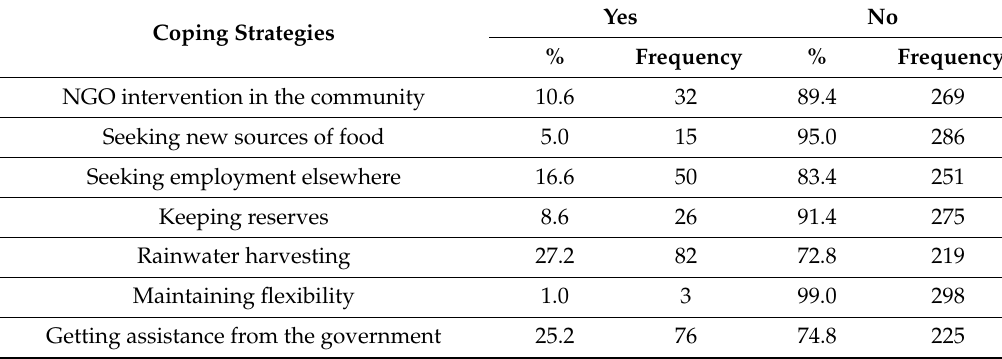
Table 3. Respondents’ coping strategies used during the 2015 / 2016 drought.